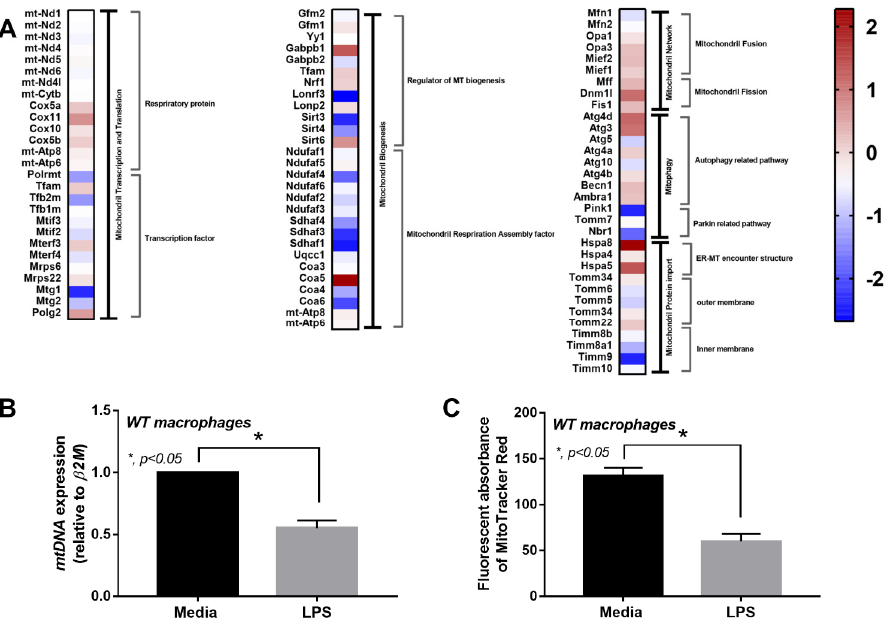
Figure 6. Characteristics of macrophages from wildtype (WT) mice after an activation by media control or lipopolysaccharide (LPS), as indicated by the heat-map of mitochondria-associated genes from RNA sequencing analysis ( A ) and mitochondrial abundance using mitochondrial DNA (mtDNA) and MitoTracker fluorescent staining ( B , C ). Independent triplicated experiments were performed. MT, mitochondria; ER-MT, endoplasmic reticulum-mitochondria.